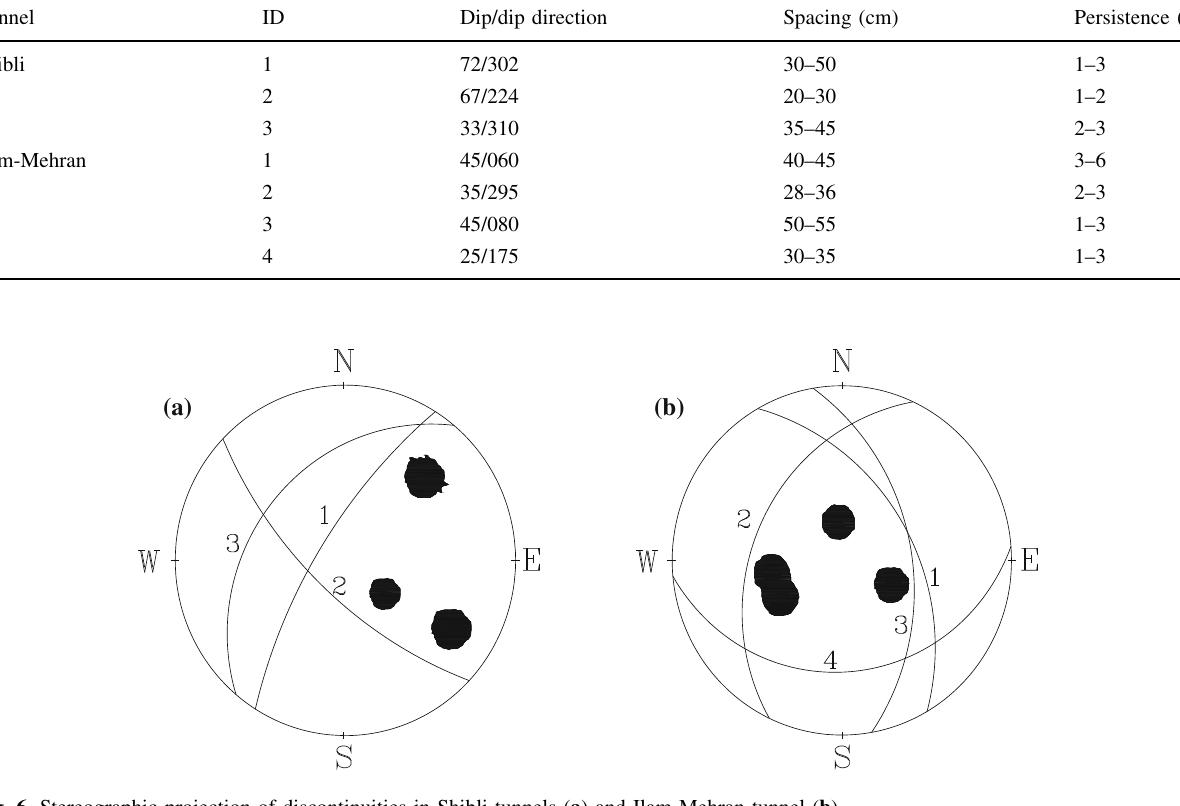
Fig. 6 Stereographic projection of discontinuities in Shibli tunnels ( a ) and Ilam-Mehran tunnel ( b ) Table 4, confirmed a moderate-to-high swelling potential.